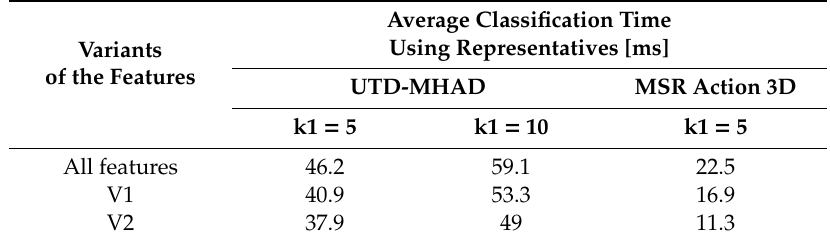
Table 13. Comparison of average classification times for tested sets and k-NN using representatives.